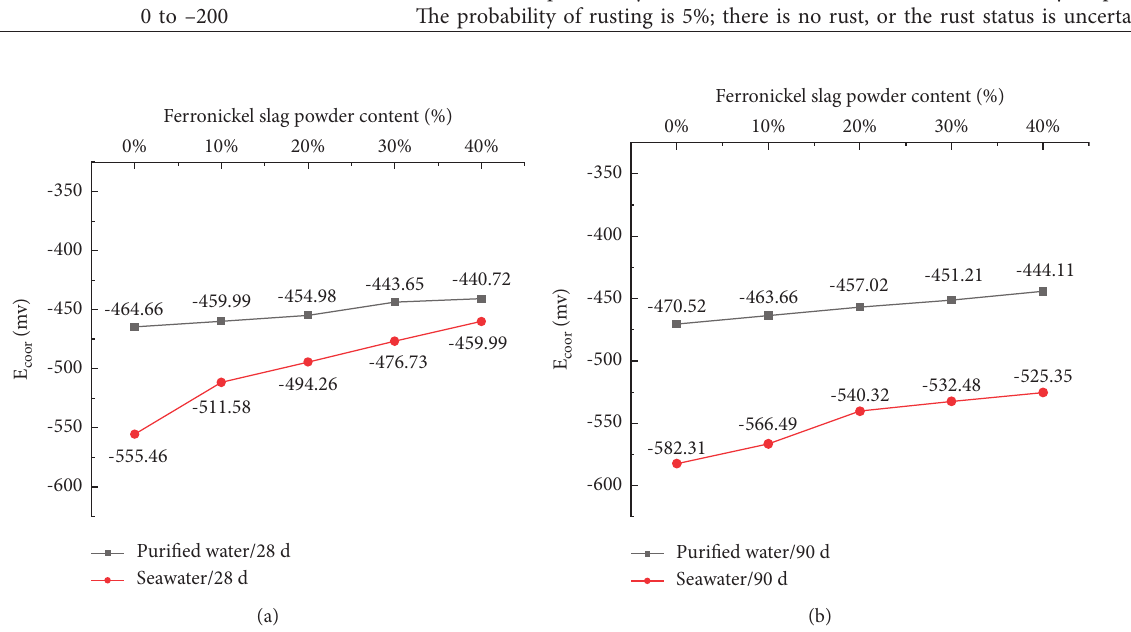
Figure 12: The comparison of the self-corrosion potential of the steel bars at a curing period of (a) 28 days and (b) 90